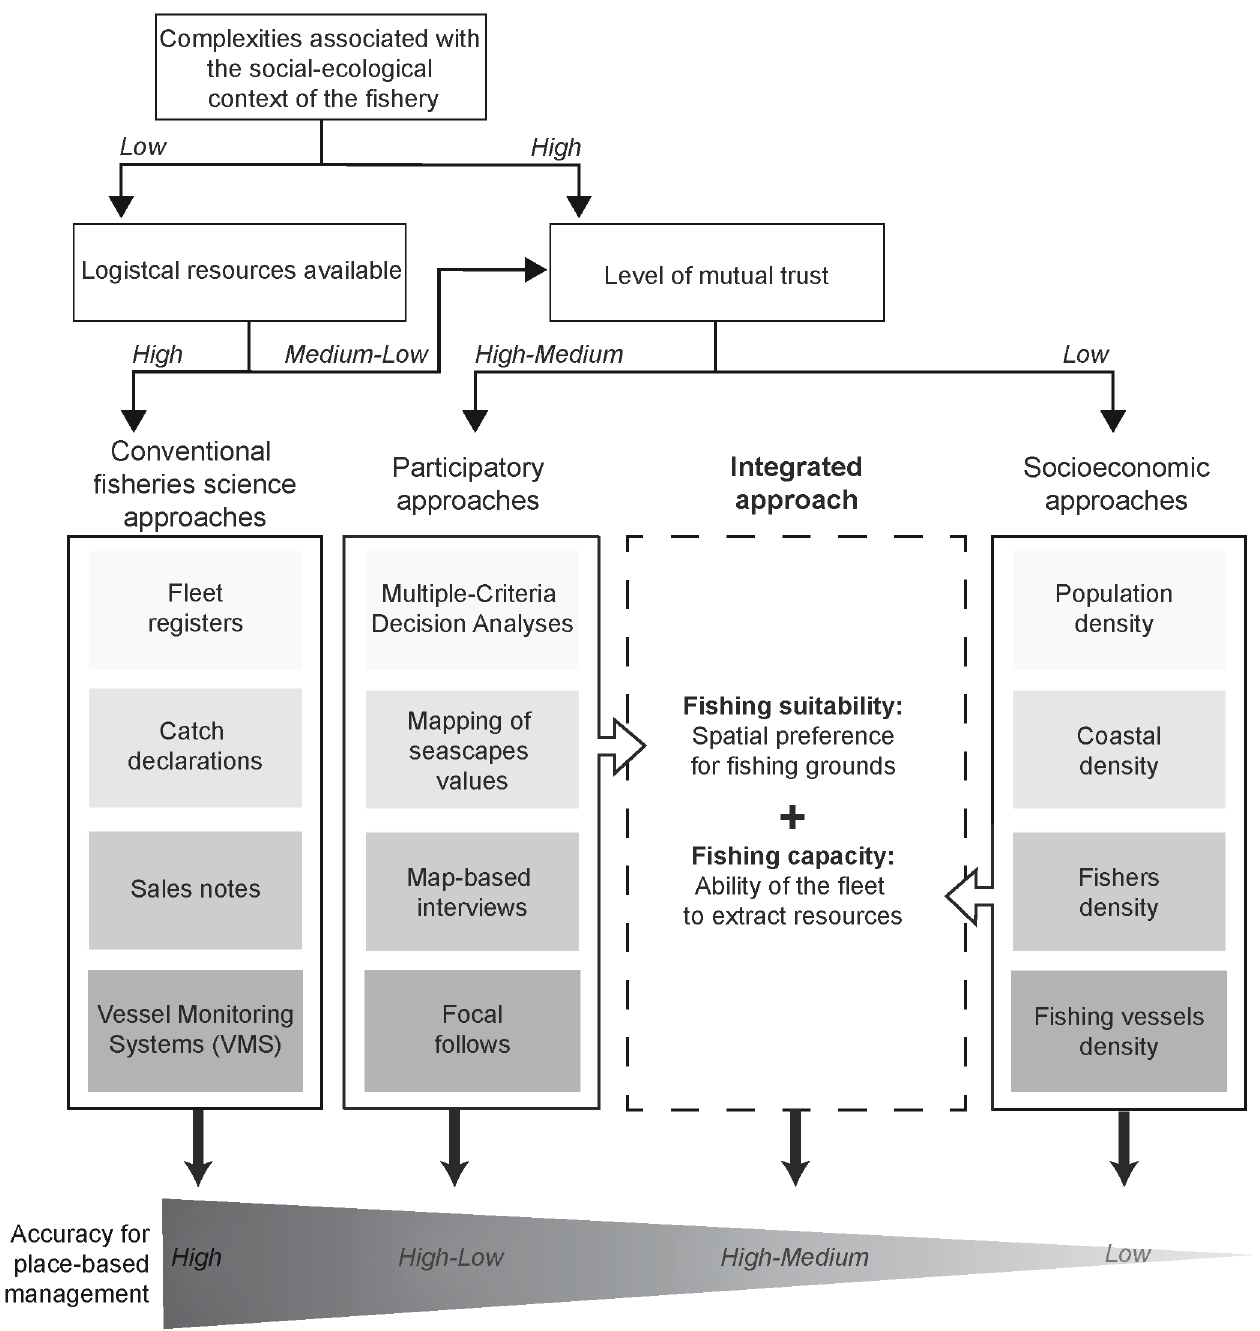
Fig 1. Conceptual flowchart for selecting the best approach to map fishing effort according to availability of three critical factors to be considered by practitioners, namely the complexity of the social-ecological context, the availability of human and financial resources and the degree of cooperation possible with local fishers (i.e., mutual trust level). Techniquescommonlyused in each type of approach are indicatedin boxes. The accuracy of each approachfor place-based management (i.e., reliabilityof the gatheredinformation, level of accuracy/ resolutionachievedand add-oninformation gatheredduringdata collection)is provided.Although providingthe most accurate estimates of fishing effort, fisheries approachesare unlikely to work in most small-scalefisheries due to the inherentcomplexity of the social-ecologicalcontext and the recurrent lack of logisticalresources. Dependingon the degreeof participants’ engagement in the participatoryprocess, informationgathered through participatory approachescan be either highly (e.g., using self-reporting diaries and map-based interviews) or moderately (e.g., collective mappingof seascapesvalues and weightings of spatially-explicit criteria through Multiple-Criteria DecisionAnalysis)relevant for place-based management. Socioeconomic approachesrely on the extrapolation of social surrogates such as total or coastal population density, fisher or